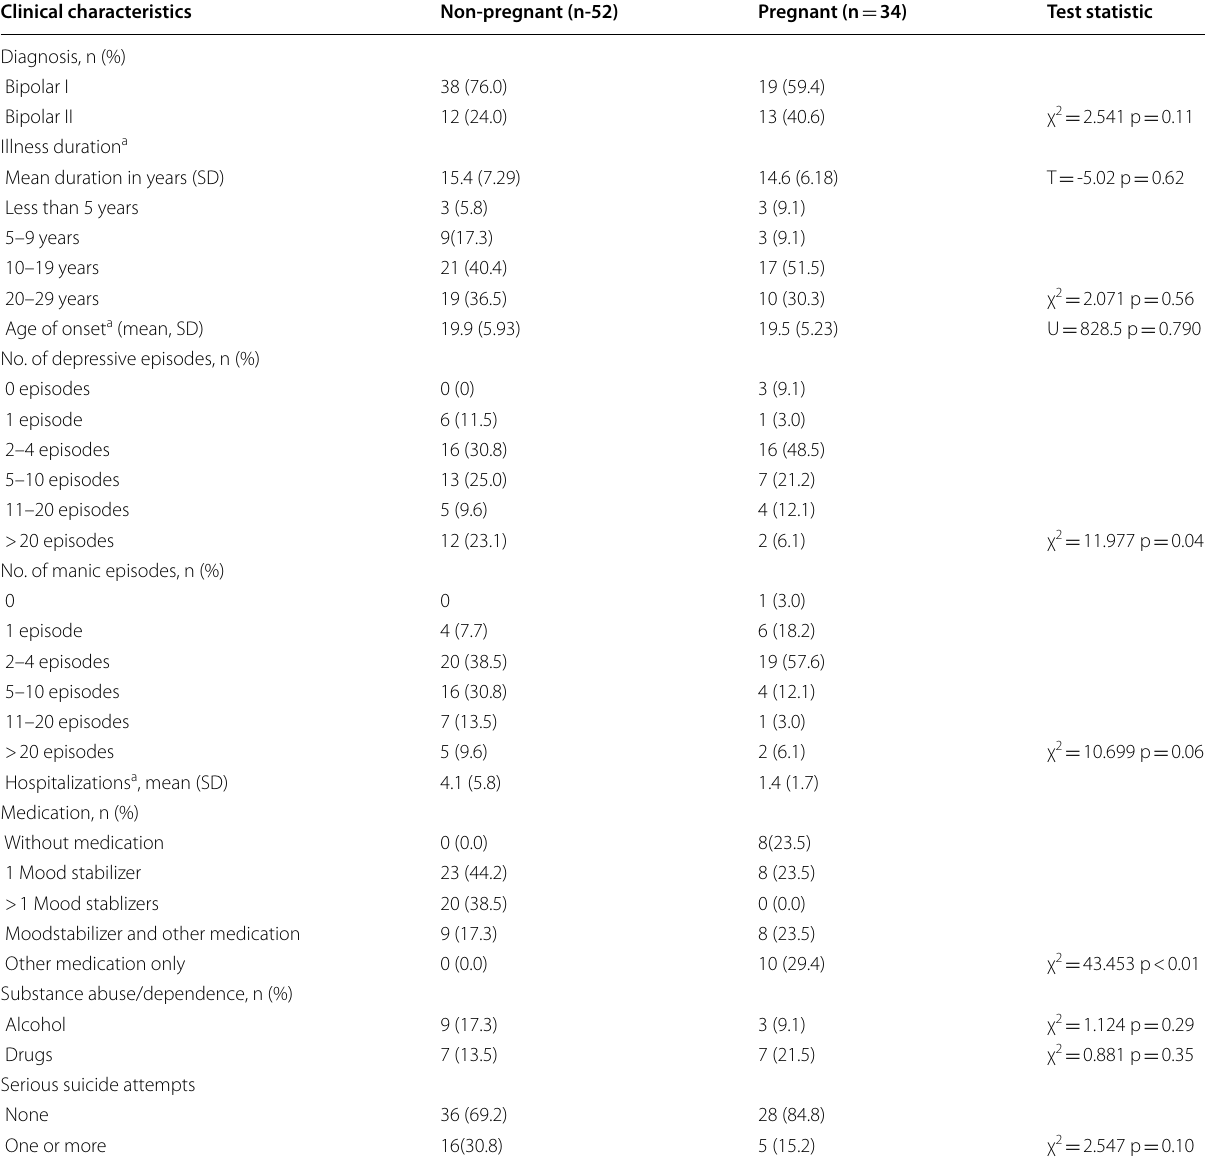
Table 2 Lifetime clinical characteristics of non‑pregnant and pregnant women with BD recruited from two study cohorts from The Clinical